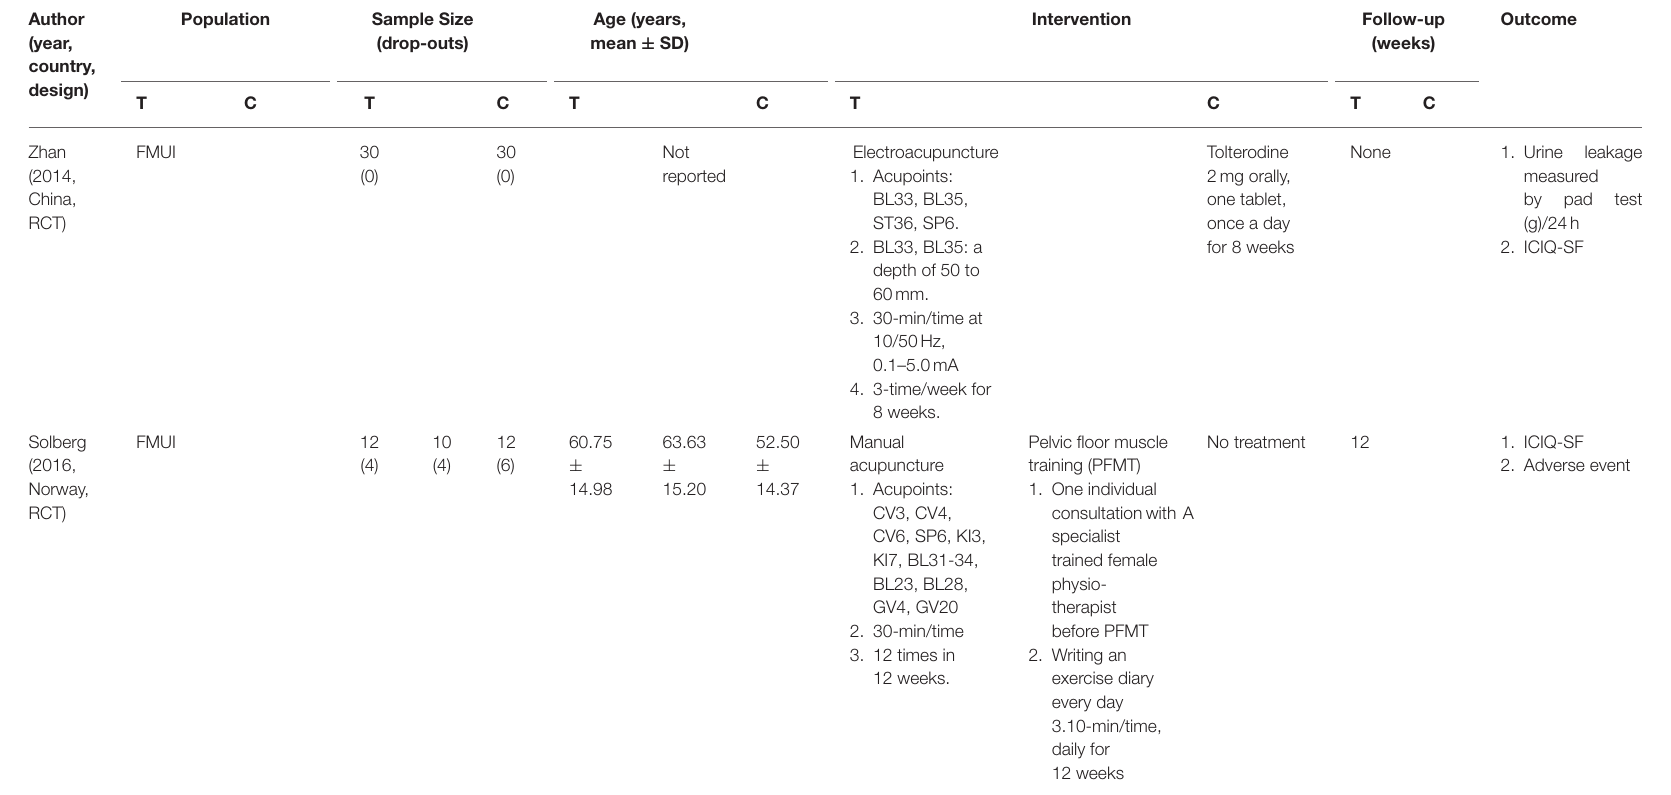
TABLE 1 | Characteristics of studies included in the